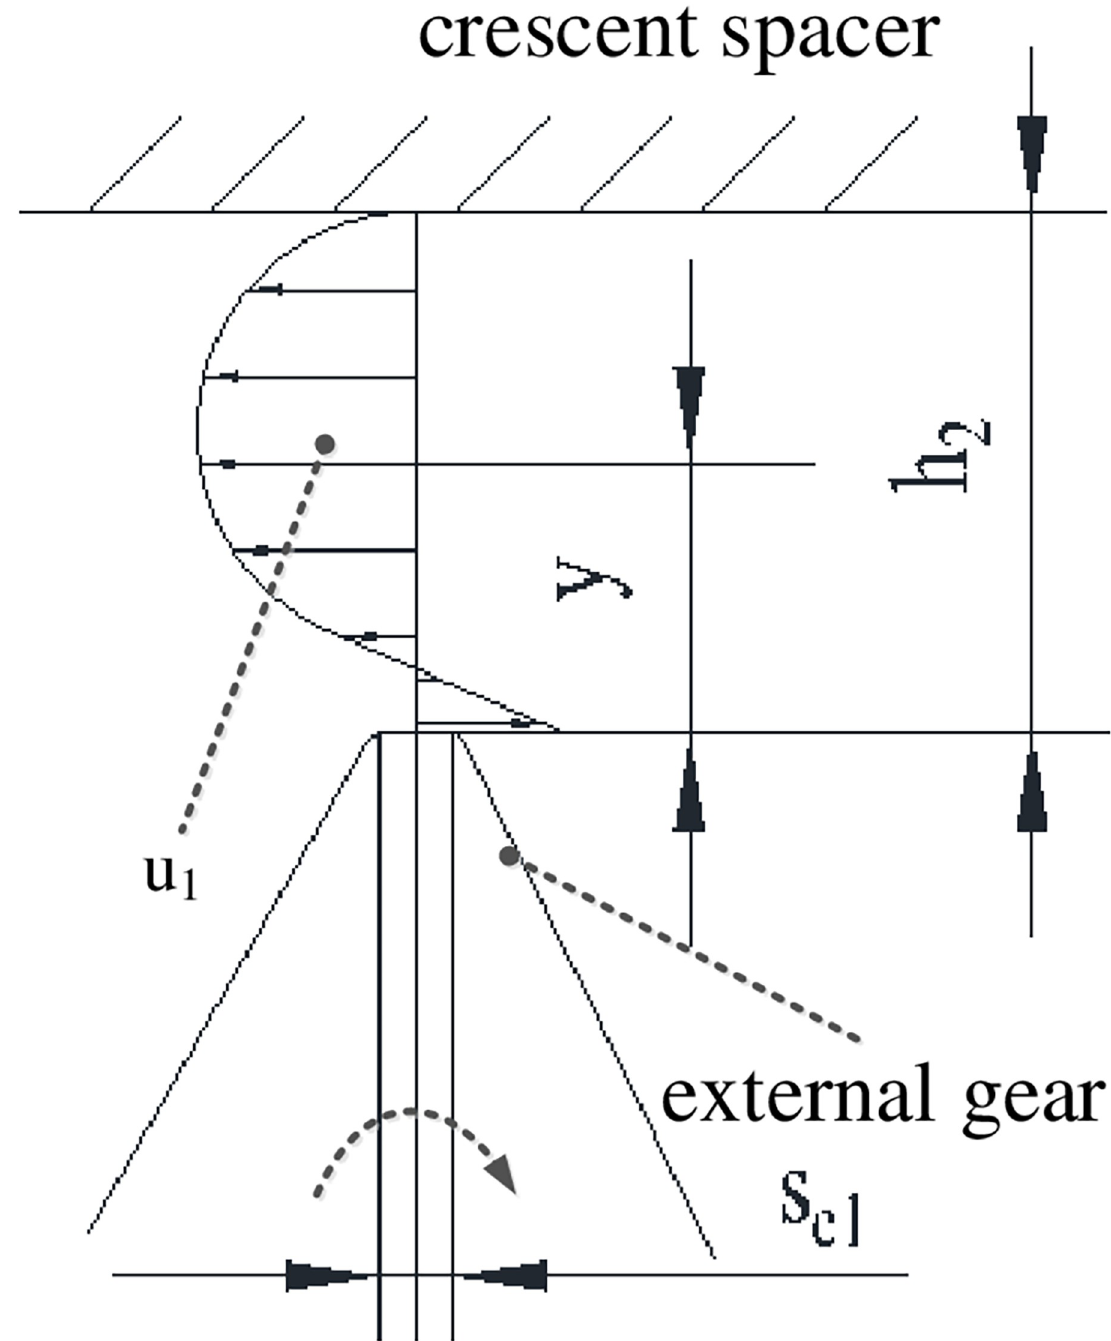
Fig 6. Distribution diagram of fluid velocity between external gear addendum and crescent diaphragm.